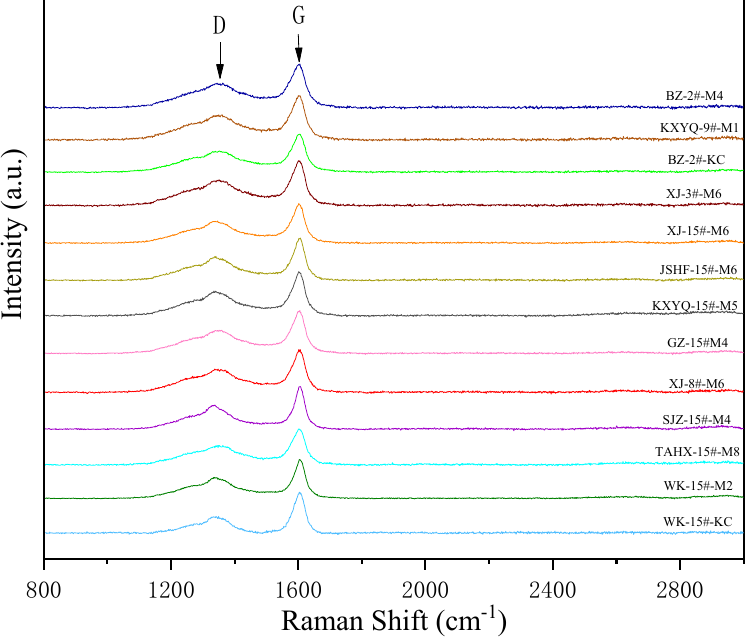
Figure 7. Raman patterns of raw coal. Table 5. Raman parameters of raw coal.